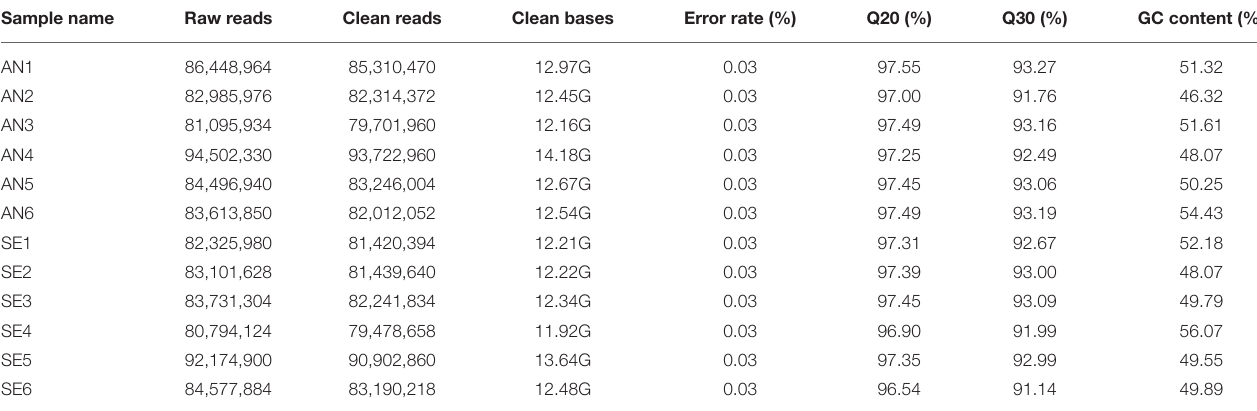
TABLE 1 | Summary of the sequencing